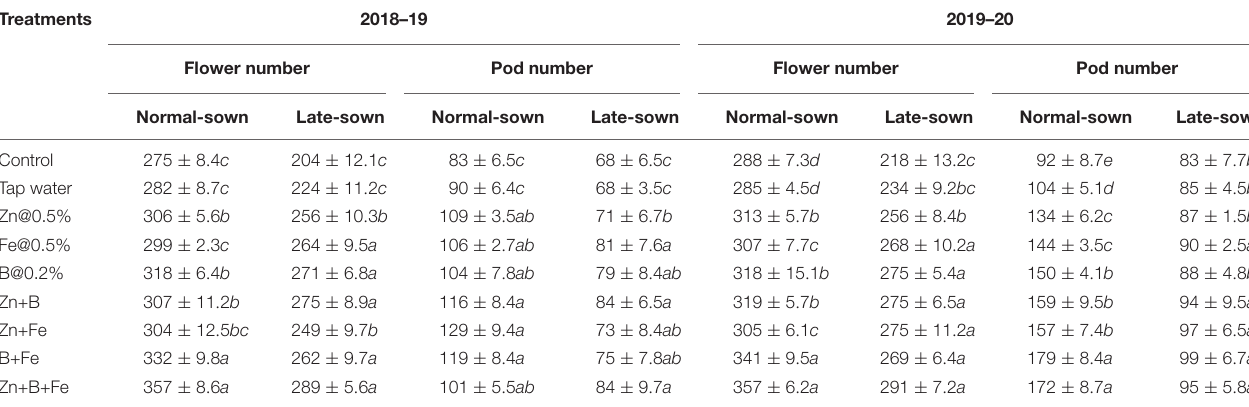
TABLE 6 | Effect of sowing time and zinc, iron, and boron foliar sprays on flower and pod numbers. Treatments